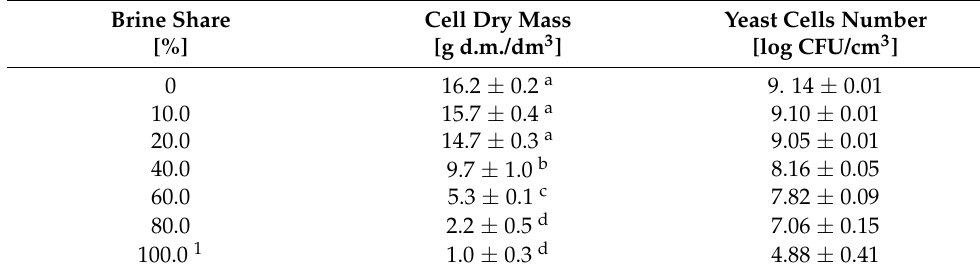
Table 3. Cell dry mass and yeast cells number in YPpfWO flask shaken cultures of Y. lipolytica . Medium ingredients were dissolved with distilled water and waste brine at different proportions. The values with the same letter in a column did not differ significantly ( α =